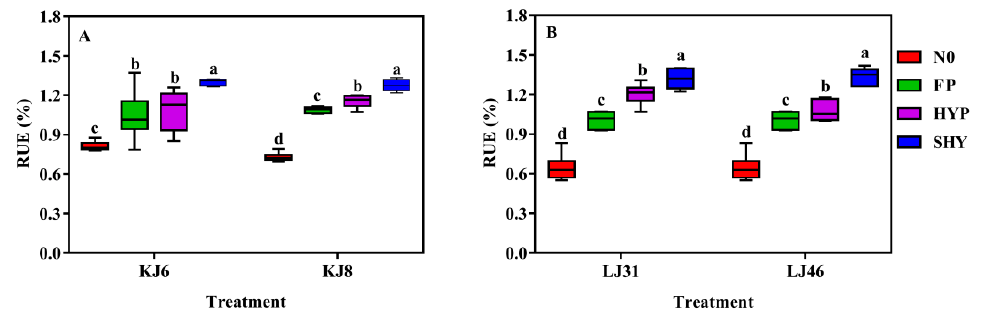
Figure 4. Radiation-use efficiency (RUE) of different varieties at different sites (( A ) in Daqing; ( B ) in Suiling) and under different cultivation patterns (N0, FP, HYP, and SHY). KJ: Kenjing 6; KJ8: Kenjing 8; LJ31: Longjing 31; LJ46: Longjing 46; N0: no nitrogen application; FP: local farmer practice; HYP: high-yield, high-efficiency practice; SHY: super-high-yield practice. Bars are mean ± SE ( n = 3). Different letters indicate statistical significance at the p < 0.05 level under different treatments .